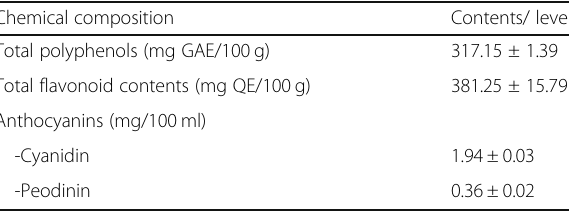
Table 2 Chemical composition of Maoberry extract Chemical